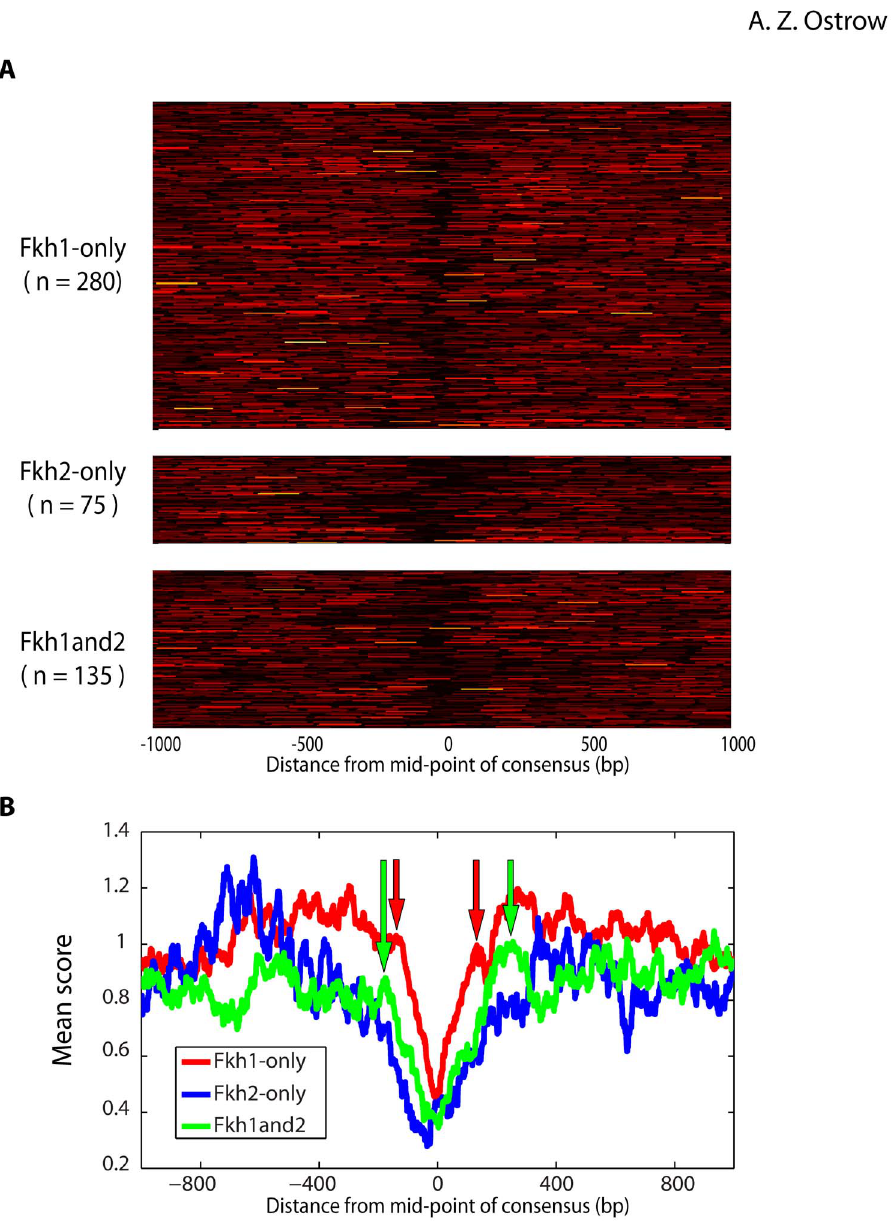
Figure 3. Distinct nucleosome positioning at Fkh1-only loci versus loci that bind Fkh2. A) The heat maps show density of MNase- protected sequences (Eaton et al 2010) for 2 kb regions centered on Fkh1/2 consensus sequences within enriched regions that have only a single Fkh1/2 consensus sequence. B) Averaged signal intensities from (A) are plotted. Arrows indicate the positions used to estimate length of nucleosome-depleted regions reported in the Results .